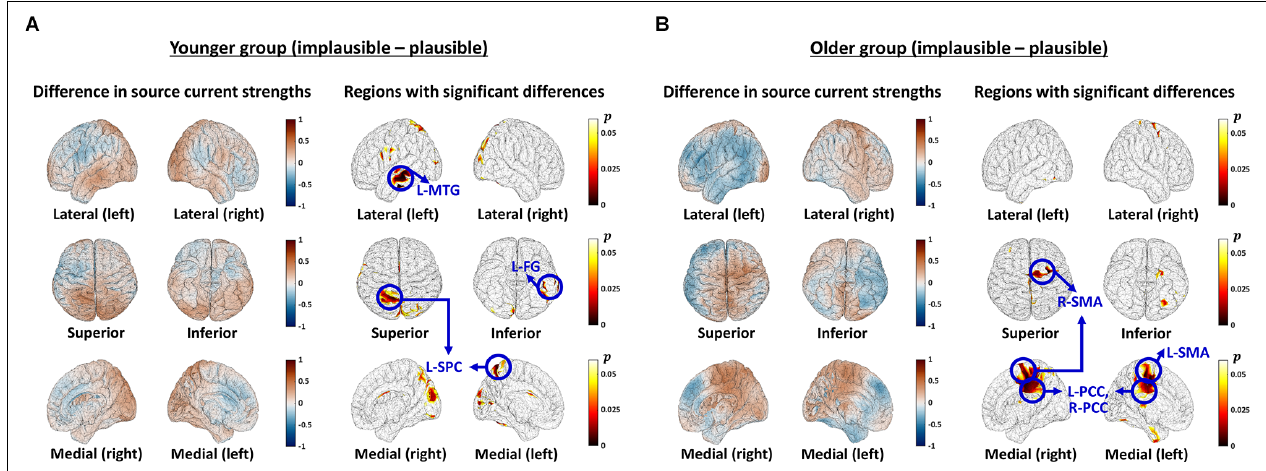
FIGURE 3 | Differences in brain activation patterns according to plausibility conditions. (A,B) Outcomes in the younger (A) and older (B) groups. In each figure, the left columns present the average results across the whole-brain, indicating brain areas that are more (red) or less (blue) activated in the implausible condition than in the plausible condition. The right columns exhibit the areas with significant differences depending on the plausibility conditions, and the color code indicates p values. The areas that showed distinct differences with significance level p < 0.01 are marked by blue circles. The sub-figure depicts the results in the lateral (left/right) view, superior/inferior view, and medial view (left/right). L-MTG, left middle temporal gyrus, L-FG, left fusiform gyrus, L-SPC, left superior parietal cortex, L-(R-)SMA, left (right) supplementary motor area, L-(R-)PCC, left (right) posterior cingulate